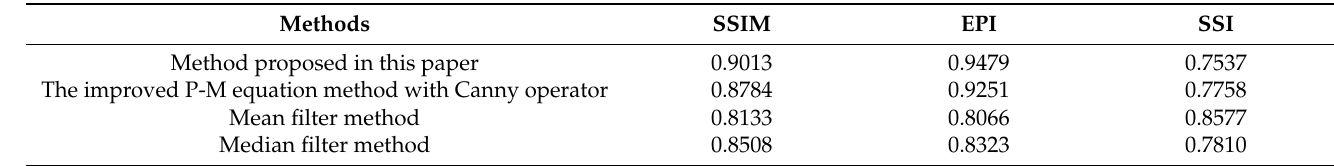
Table 1. SSIM, EPI and SSI calculation results of reconstructed phase after processing Figure 4b with different speckle suppression methods.